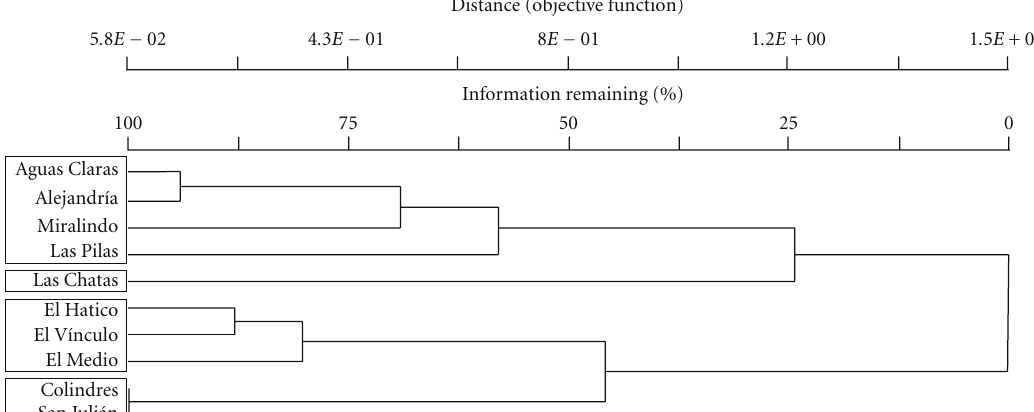
Figure 4: Clustering of the ant assemblages at the 10 sampled sites, based on the Sorensen (Bray-Curtis) index of dissimilarity and the Beta-flexible clustering method ( b = − 0 . 25). Percent concatenation: 10%.